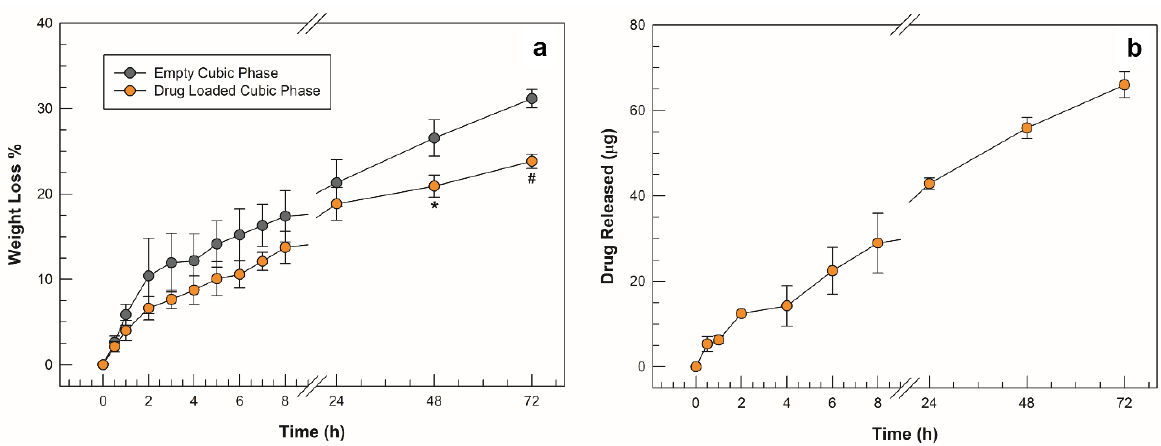
Figure 8. Degradation studies in SVF ( a ) obtained from empty cubic phase (grey symbols) and drug-loaded cubic phase (orange symbols); ( b ) amount of drug released from cubic phase vs. time. The results are expressed as mean values of three independent experiments ± standard deviation, * p < 0.05, # p < 0.001.